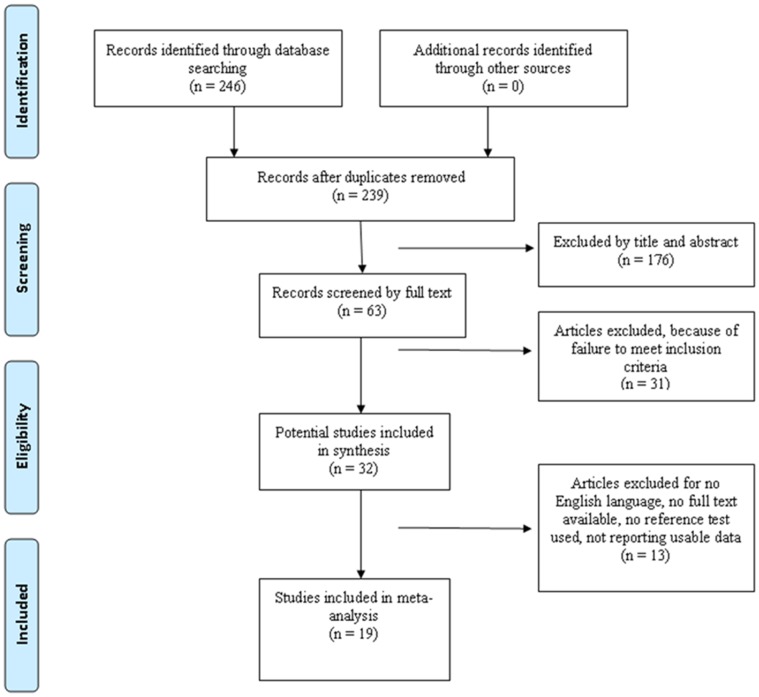
The study selection and inclusion process.